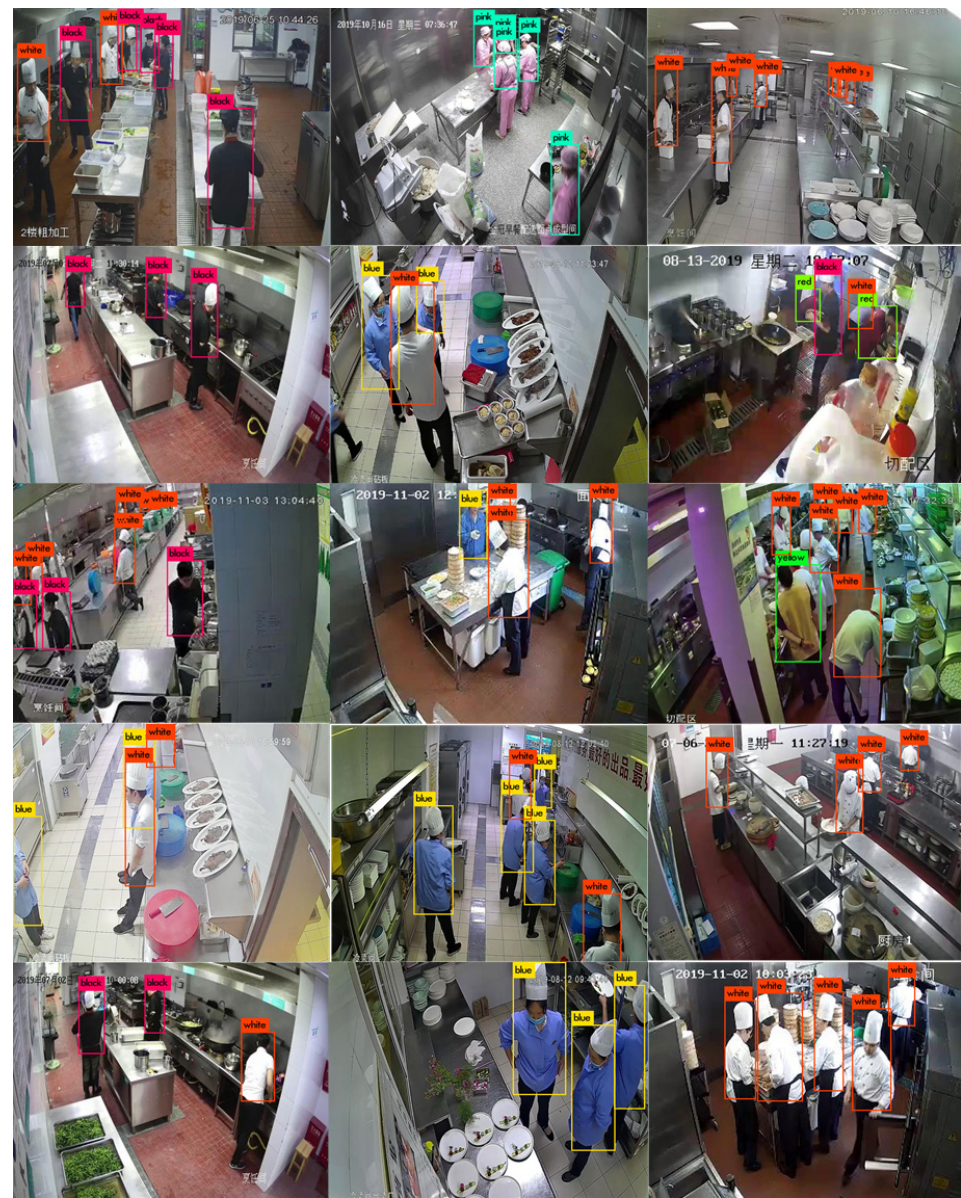
Figure 19. Field test results.